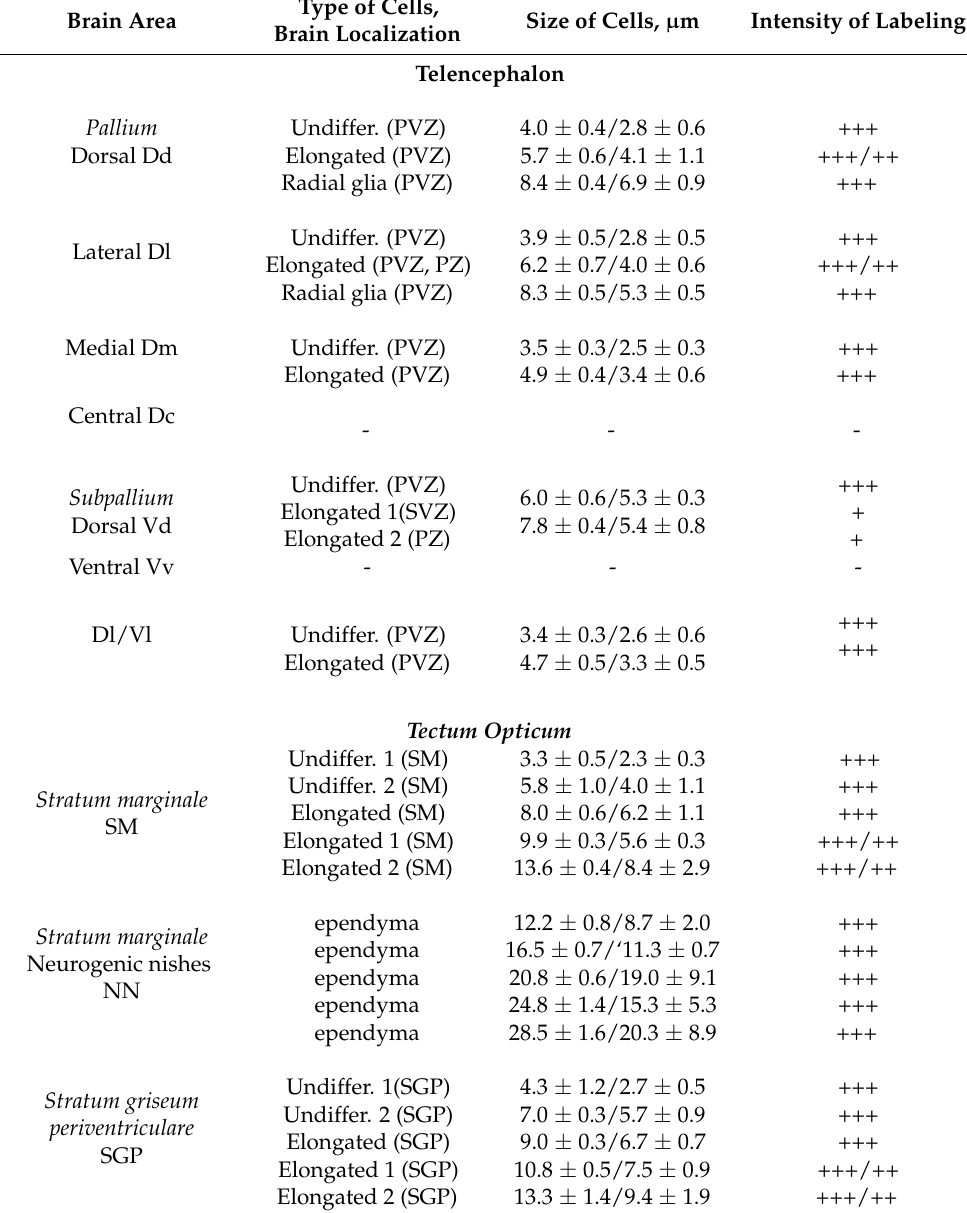
Table 3. Morphometric and densitometric parameters (M ± SD) of vimentin-immunopositive cells in the telencephalon and optic tectum of trout, Oncorhynchus mykiss